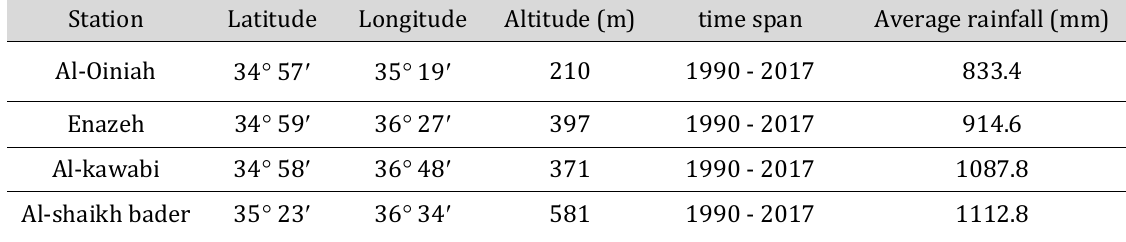
Table 1. Rainfall stations in the study